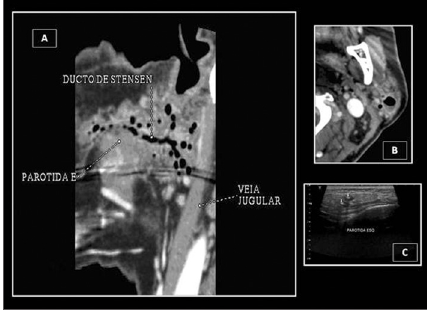
Figura 1. Aspecto radiológico da pneumoparotidite por tomo- grafia (A e B) e por ultrassonografia